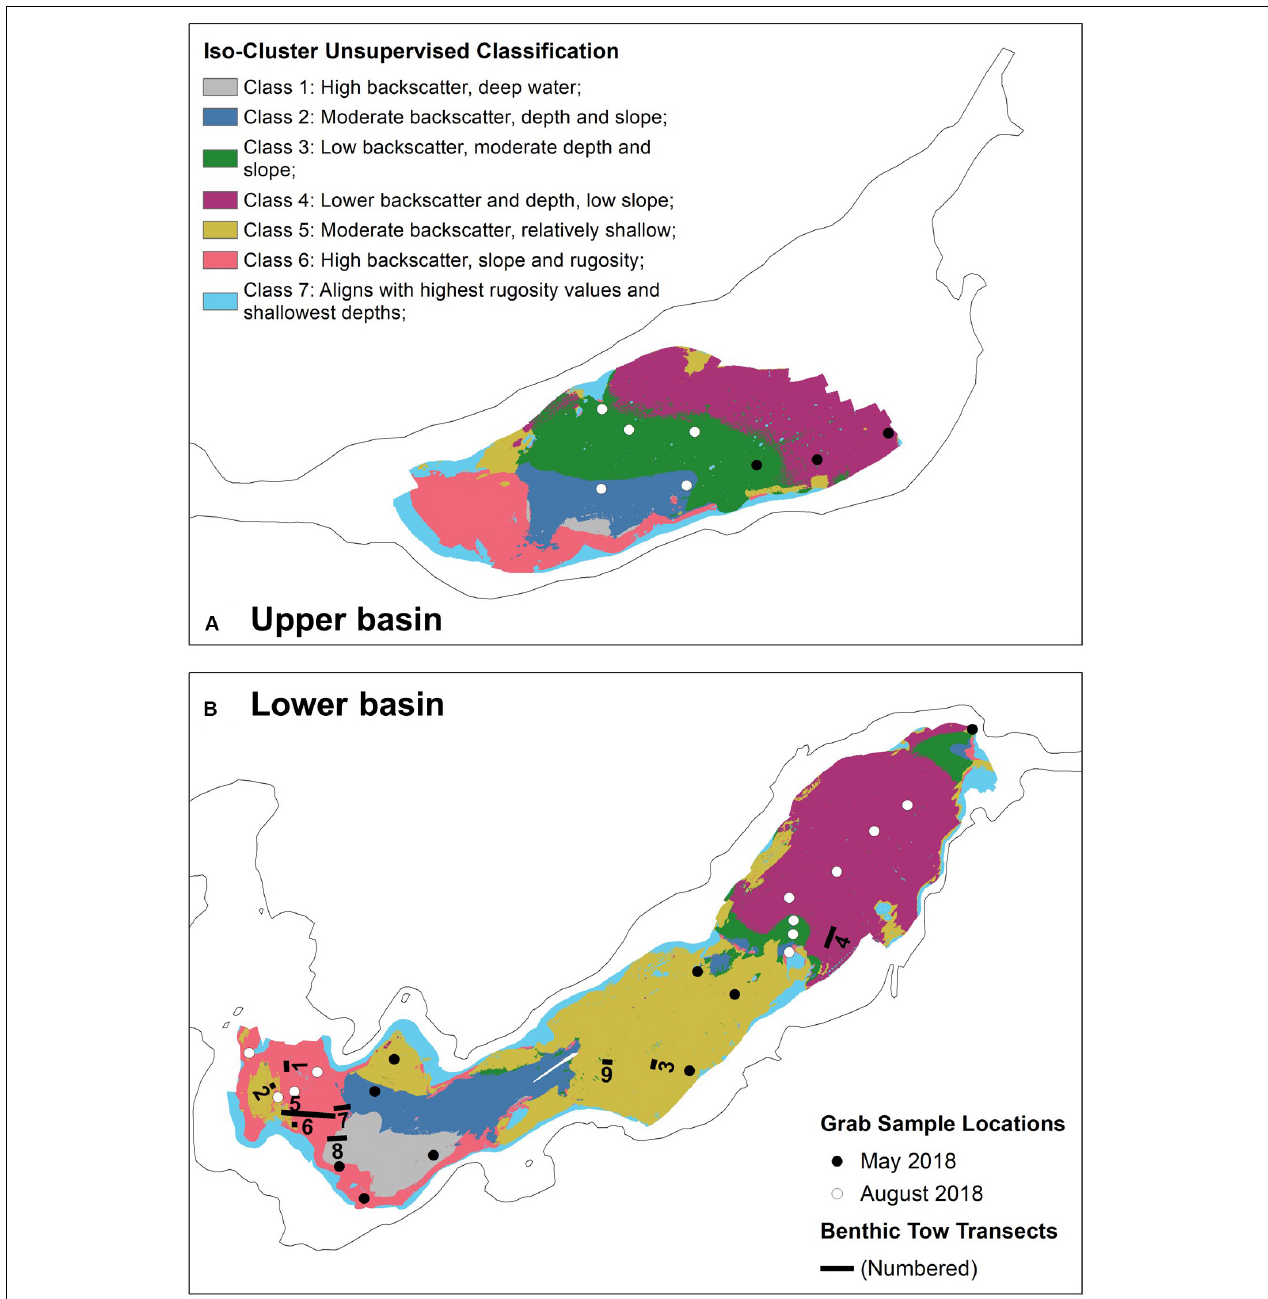
FIGURE 3 | Classified maps of Loch Creran split into (A) Upper basin and (B) Lower basin, using Unsupervised Iso-Cluster tool, showing the ground-truth sample locations collected in May 2018 (black circles) and August 2018 (white circles). The benthic tow transects carried out in the Lower basin are shown as numbered solid black